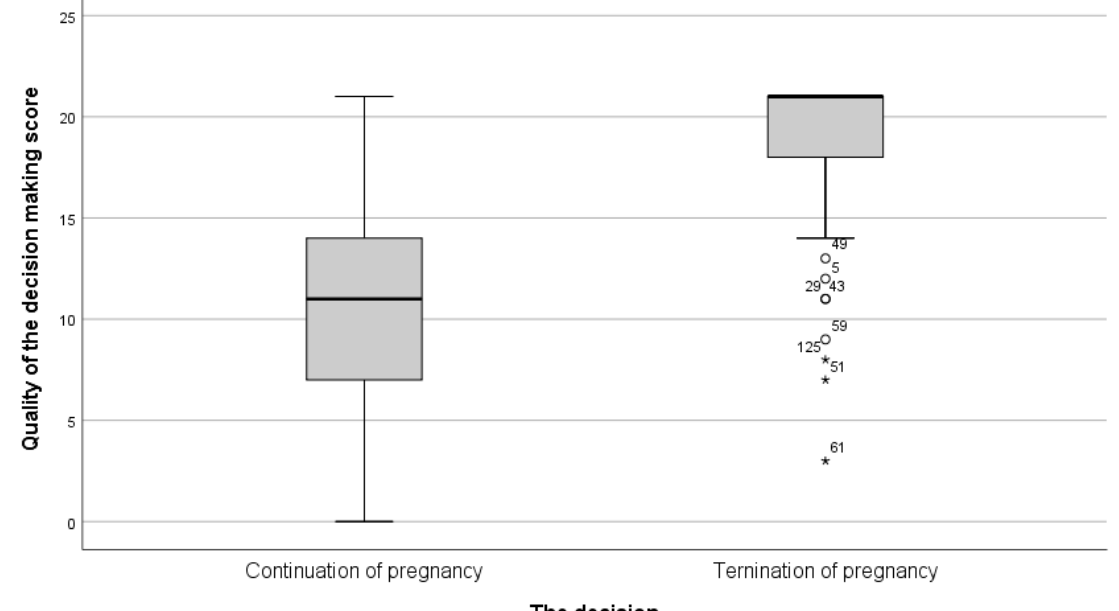
Figure 1. Differences in the total scores of ‘vigilant information processing’ between ‘continuation of pregnancy’ and ‘termination of pregnancy’ groups. t = 13.587, p < 0.001. * Mean and median scores of the quality of the decision-making process: ‘Continuation of pregnancy’ group: M (SD) = 10.15 (5.6); Med [range] = 11 [0–21], ‘Termination of pregnancy’ group: M (SD) = 18.51 (3.9); Med [range] = 21 [3–21].